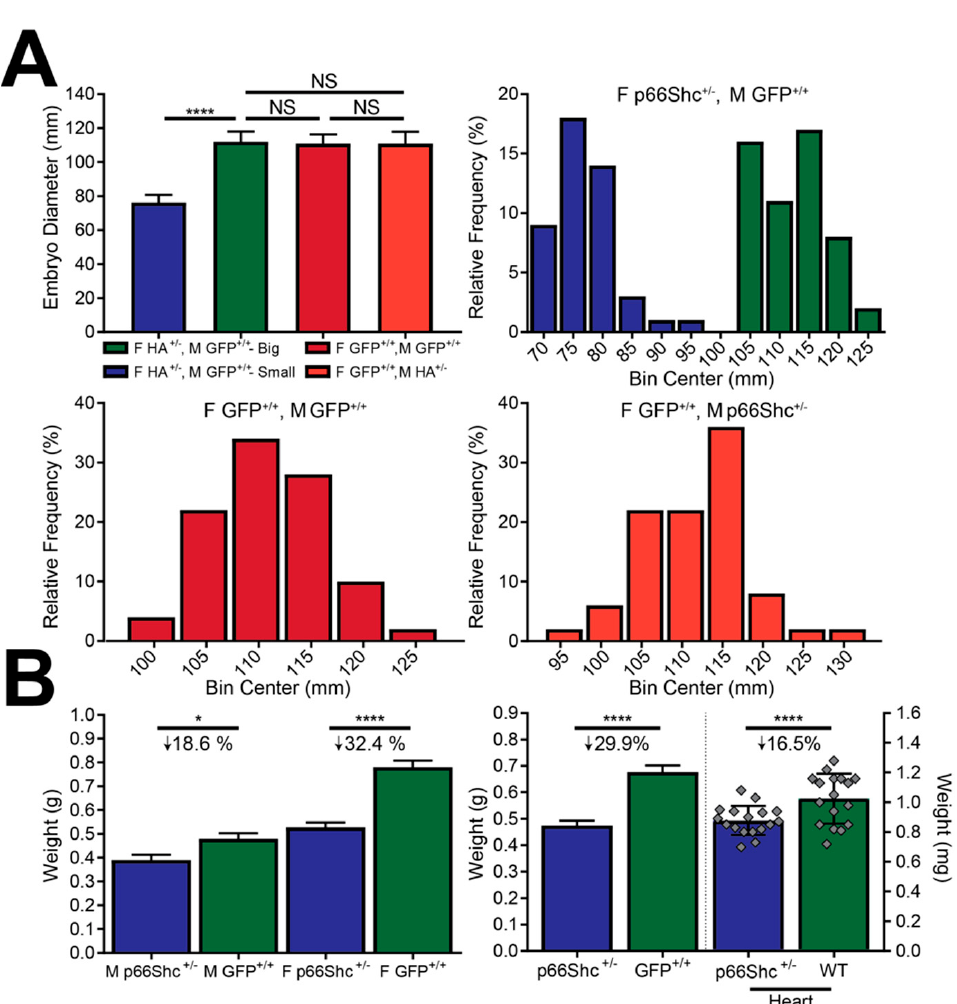
Figure 4. p66Shc hypomorphic allele embryo diameter and adult zebrafish mass. ( A ) Embryo diameter (top left panel) and embryo diameter frequency distribution of different parental crosses. p66Shc hypomorphic allele heterozygote females produce embryos with a bimodal size distribution that can be separated under a microscope. Size differences were significant and not observed when female WT (F GFP +/+ ) fish were bred with male WT (M GFP +/+ ) or male p66Shc +/ − (M hypomorphic allele (HA) +/ − ). Parental genotypes are indicated by color and above their corresponding histograms. N = 50, **** = p < 0.0001, mean ± SD. ( B ) Whole fish weight differences (left panel) by gender and genotype. Males had a smaller mass decrease than females. Whole fish and heart mass differences (right panel), not gender stratified. N = 16 (hearts) or ≥ 36 (whole fish), * = p < 0.05, mean ± SD. Individual data points omitted for clarity.